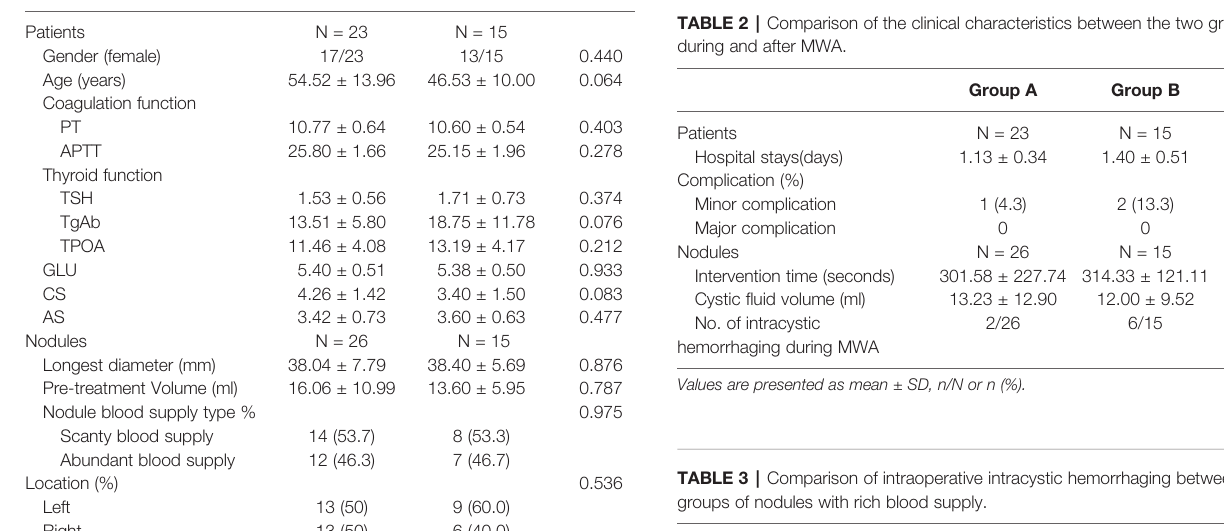
TABLE 1 | Comparison of general clinical and ultrasound characteristics between the two groups. Group A Group B P-